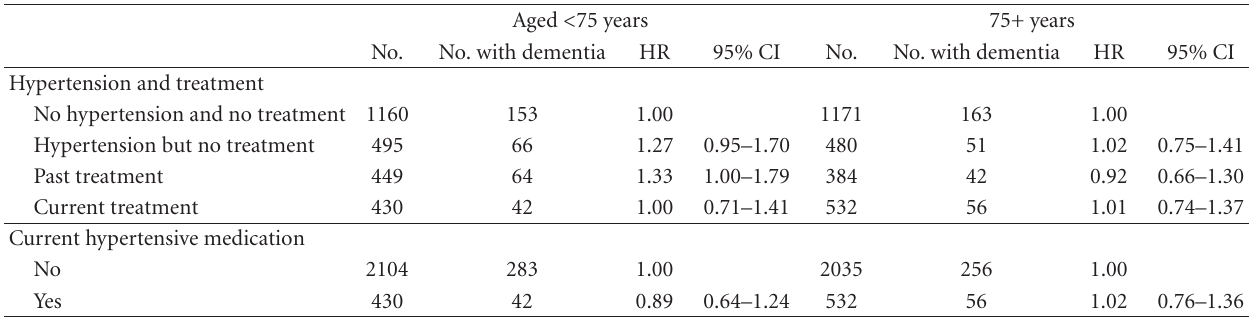
Table 2: Hazard ratios for dementia by hypertension and its treatment in men, Leisure World Cohort Study, 1981–2010.